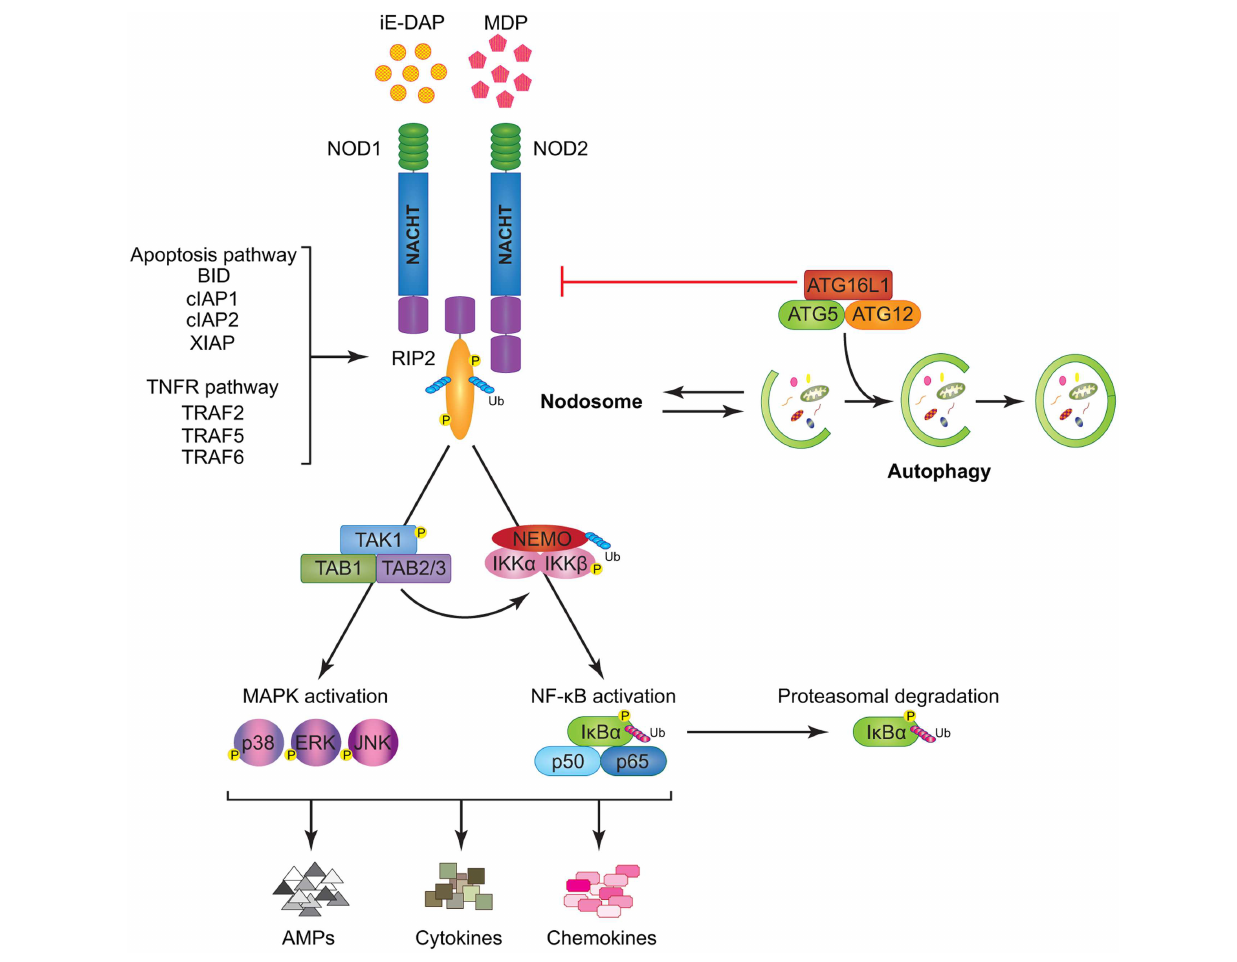
FIGURE 2 | Model of NOD1 and NOD2 signaling cascades . NOD1 and NOD2 recognize bacterial PGNs, iE-DAP, and MDP, respectively. Following ligand sensing the NODs recruit their common adaptor RIP2 by CARD–CARD interactions and induce RIP2 to undergo phosphorylation.The members of theTRAF family (TRAF2,TRAF5, andTRAF6), the IAP family (XIAP, cIAP1, and cIAP2), and the BCL2 family (BID) bind to RIP2 and facilitate its ubiquitination allowing the recruitment ofTAK1 and ubiquitinated NEMO to the Nodosome. On one hand, NEMO instigates activation of the canonical NF- κ B pathway by phosphorylating IKK α and IKK β , by inducing I κ B α phosphorylation and